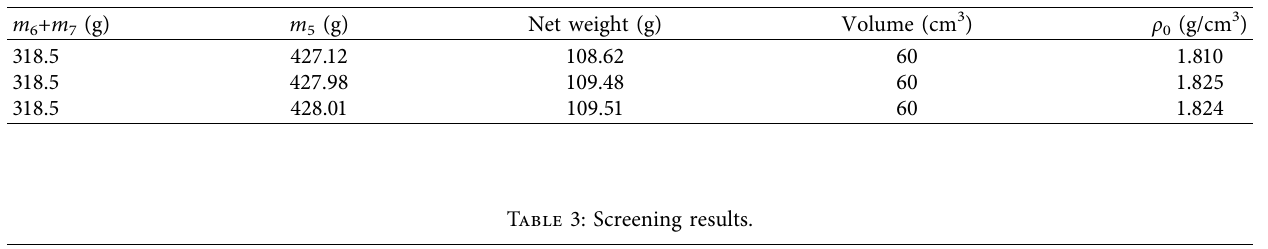
Table 2: Measured